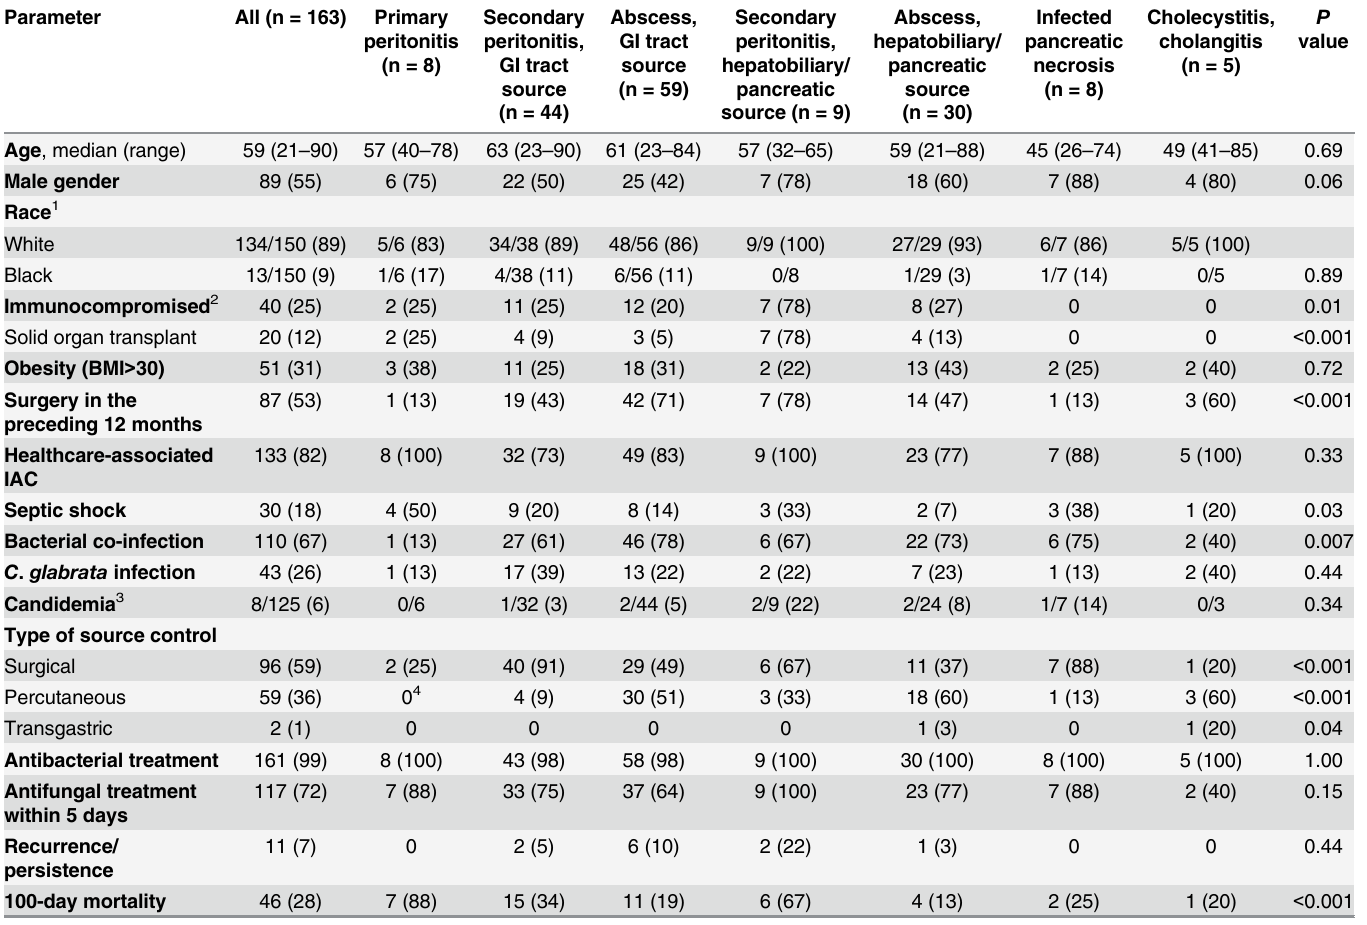
Table 2. Clinical characteristics, treatment and outcomes of patients with intra-abdominal candidiasis